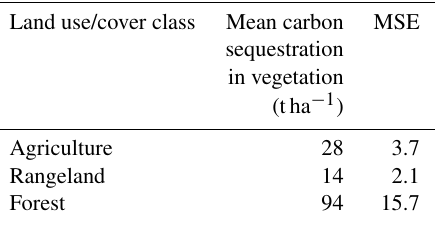
Table 7. Carbon sequestration in vegetation per land use/cover class, using dry plant weight method.